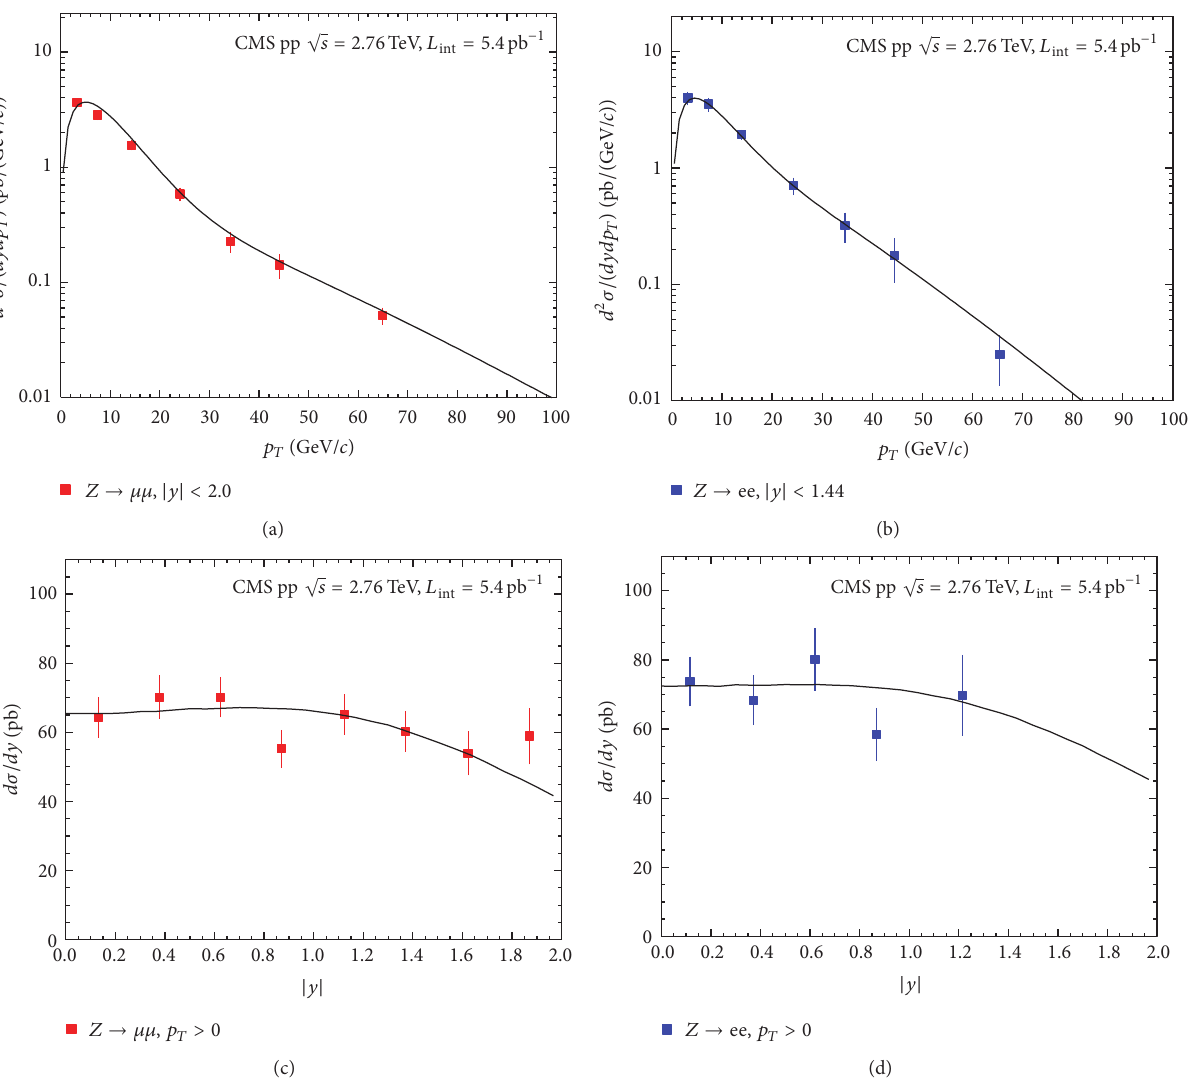
Figure 1: (a)-(b) Transverse momentum spectra and (c)-(d) rapidity spectra of 𝑍 bosons produced in pp collisions at √𝑠 = 2.76 TeV, for the (a)-(c) dimuon ( 𝜇𝜇 ) and (b)-(d) dielectron (ee) decay channels in |𝑦| < 2.0 and |𝑦| < 1.44 , respectively, where 𝜎 on the vertical axis denotes the cross section, and the integral luminosity 𝐿 int = 5.4 pb −1 . The closed squares represent the experimental data of the CMS Collaboration [27], and the error bars are only the statistical uncertainties. The curves are our results calculated by using the (a)-(b) two-component Erlang distribution and (c)-(d) two-component Gaussian distribution,